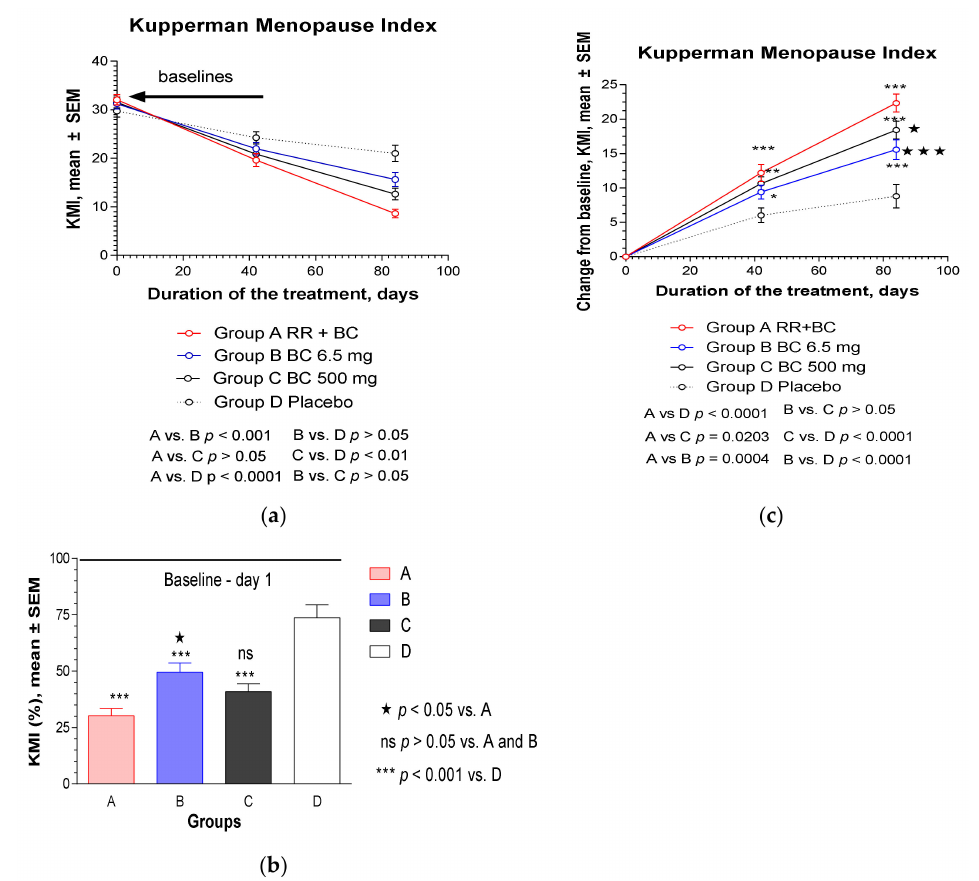
Figure 2. E ff ects of RR-BC (Group A), BC (Group B), BC500 (Group C), and placebo (Group D) on menopausal symptoms after 12 weeks (84 days) of treatment, as assessed using the KMI: ( a ) a significant decrease of KMI (mean ± SEM) score compared to baseline values was observed in all groups over time ( p < 0.0001); ( b ) a significant di ff erence in KMI (% to baseline, 100%, mean ± SEM) was observed in groups A, B, and C compared to placebo group at the end of the treatment—day 84, ( p < 0.0001), as well as between groups A and B, but not in groups A vs. C and B vs. C; ( c ) statistically significant interaction e ff ects between treatment groups and response (change from the baseline of KMI, mean ± SEM) over time showed significant di ff erence between group A and groups B, C, and D, as well as groups B vs. C and B vs. D, but not B vs. D (two-way ANOVA). The significance of di ff erence between groups at various time points, calculated by Bonferroni post-test, is expressed by symbols * p < 0.05, ** p < 0.01, *** p < 0.001, ns: not significant (A, B, and C vs. placebo); and * p < 0.05 (B vs. A), *** p < 0.001 (C vs.